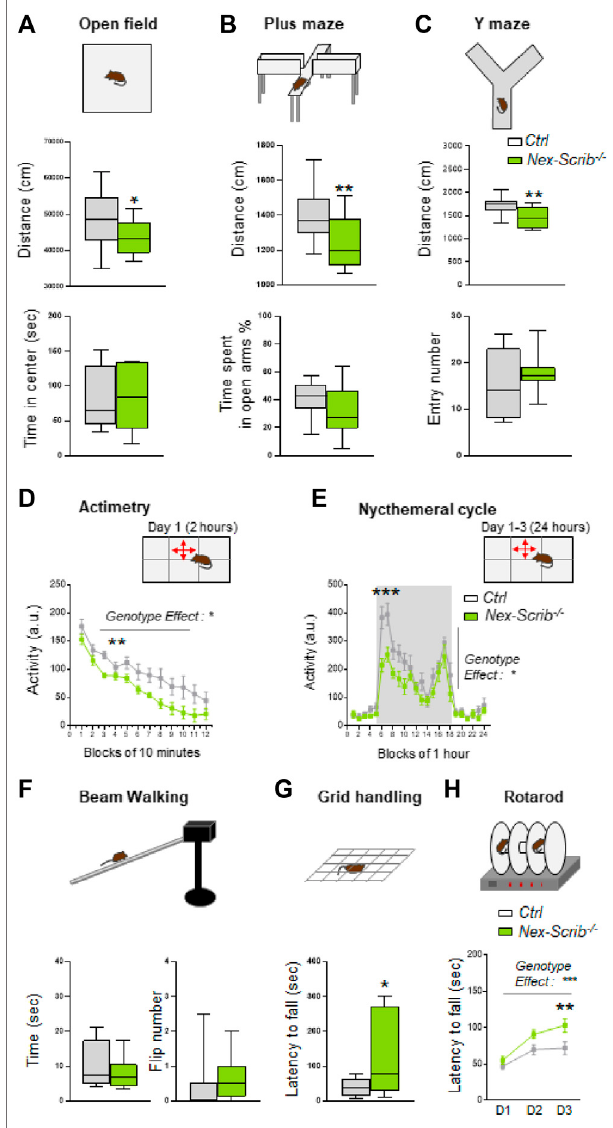
FIGURE 4 | Nex-Scrib − / − cKO mice display decreased locomotor activity andnoimpairmentofmotorcoordination. (A – H) Behavioralresponses in adult Nex-Scrib − / − cKO mice (green) as compared with their littermate control(white).Spontaneouslocomotoractivitywasmonitoredinseveral assays: in the open fi eld test (A) , in the elevated plus maze test (B) , in the Y-maze (C) , during exposure to a novel home cage (D) , and during the nycthemeral cycle (E) . Nex-Scrib − / − cKO mice travel shorter distances than their respective controls. The circadian pro fi le of the locomotor activity was measured in 1 h increments during 24 h under 12 h light (blocks 18 – 6) and 12 h dark conditions (blocks 6 – 18). (F – H) Motor coordination and balance. In the beam walking, grid handling, and rotarod tests, no defects were observed in Nex-Scrib − / − mice.Values arepresented at means ±s.e.m. from 6 – 14mice per genotype. ( *p < 0.05, **p < 0.01) versus the control littermate